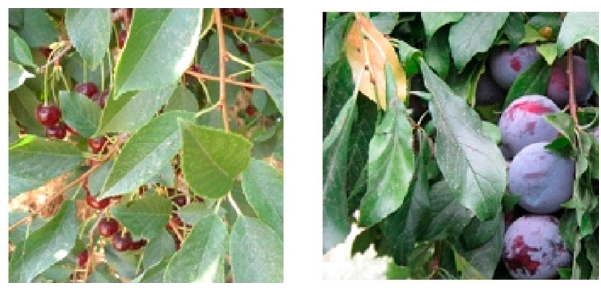
Figure 8. Image samples for fruit detection; cherries and plums with leaf–fruit overlaps [109].